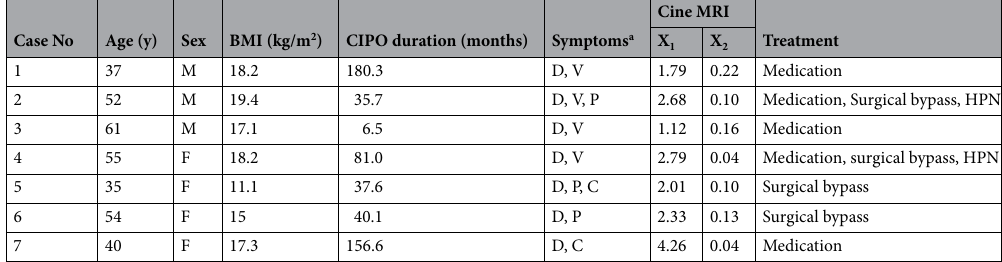
Table 1. Clinical course and cine magnetic resonance imaging findings in patients with chronic intestinal obstruction. BMI, body mass index; CIPO, chronic intestinal obstruction; HPN, home parenteral nutrition; MRI, magnetic resonance imaging. a D: abdominal distention, V: vomiting, P: Abdominal pain, C: constipation. x 1 : the logarithm of the Mahalanobis distance, x 2 : the distance variation per